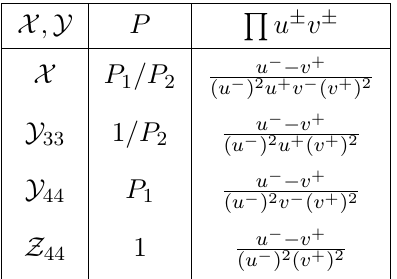
Table 2 . Reduced table for the non-factoring diagonal matrix